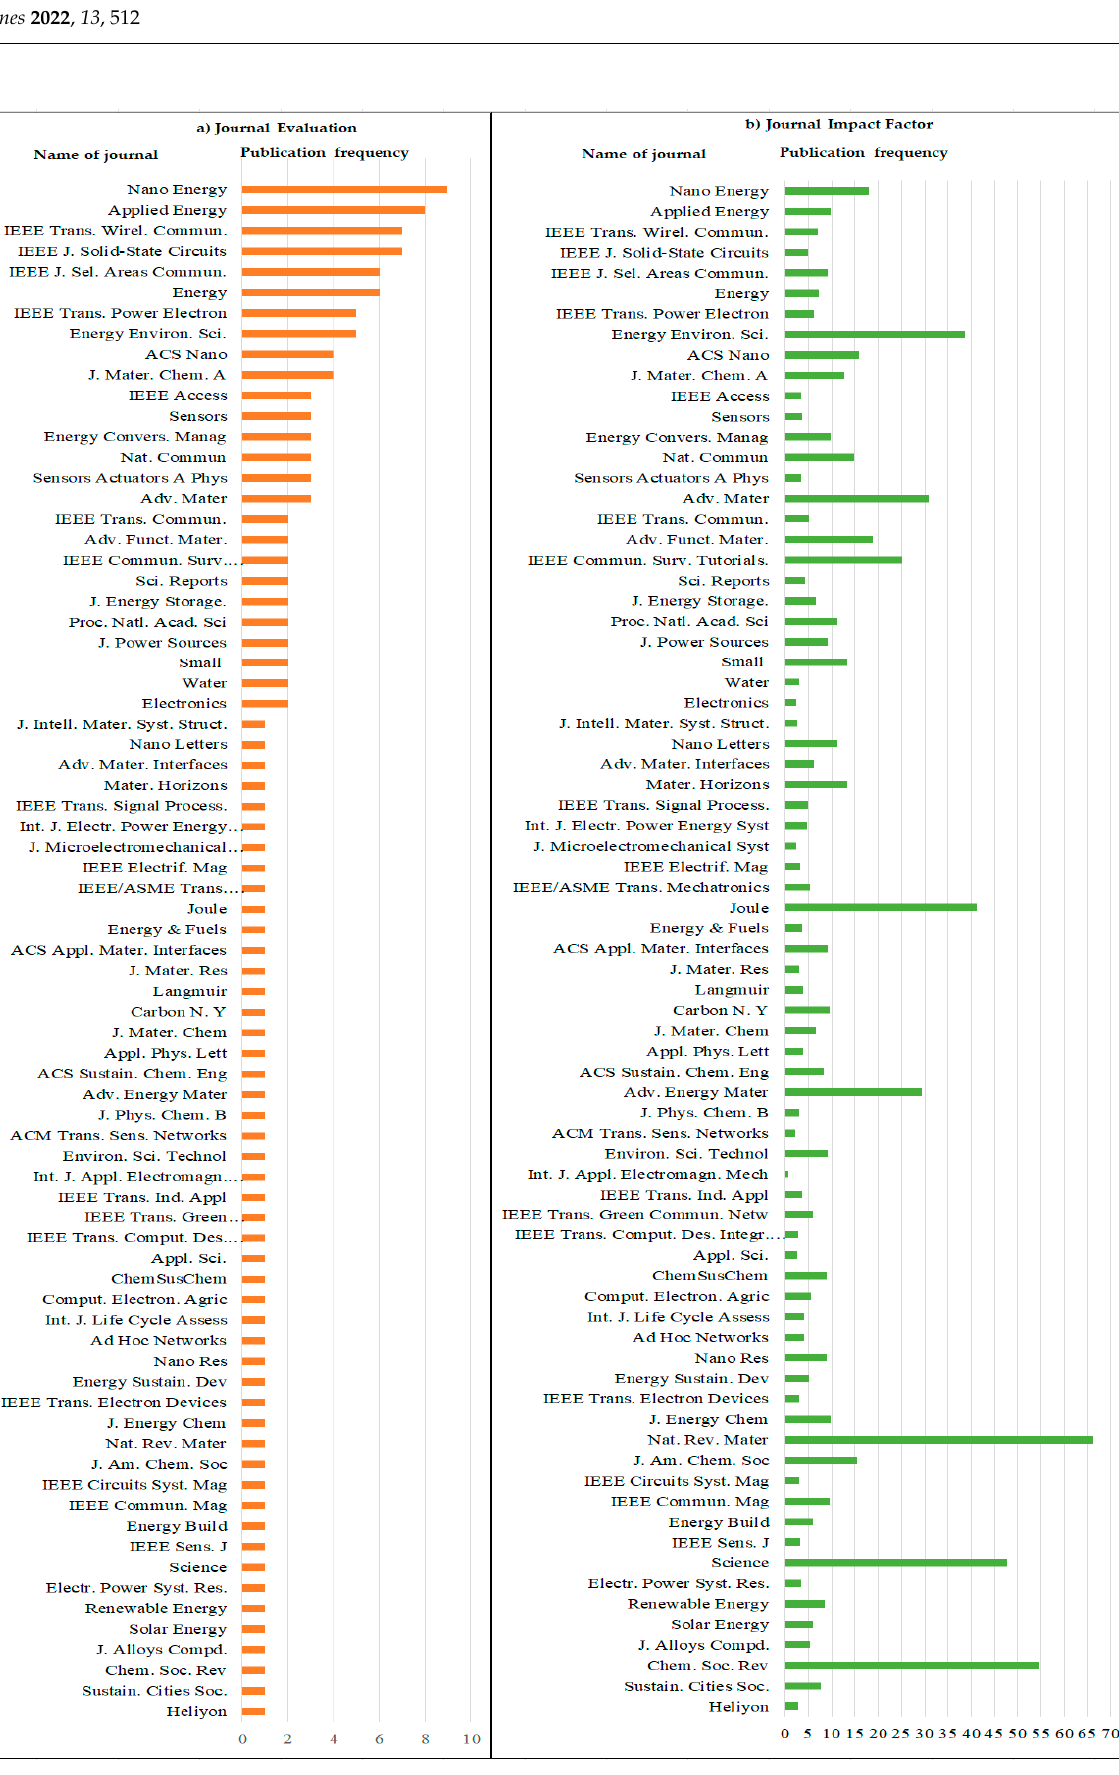
Figure 7. ( a ) Frequency of manuscripts published in different journals ( b ) Impact factor of this journal.